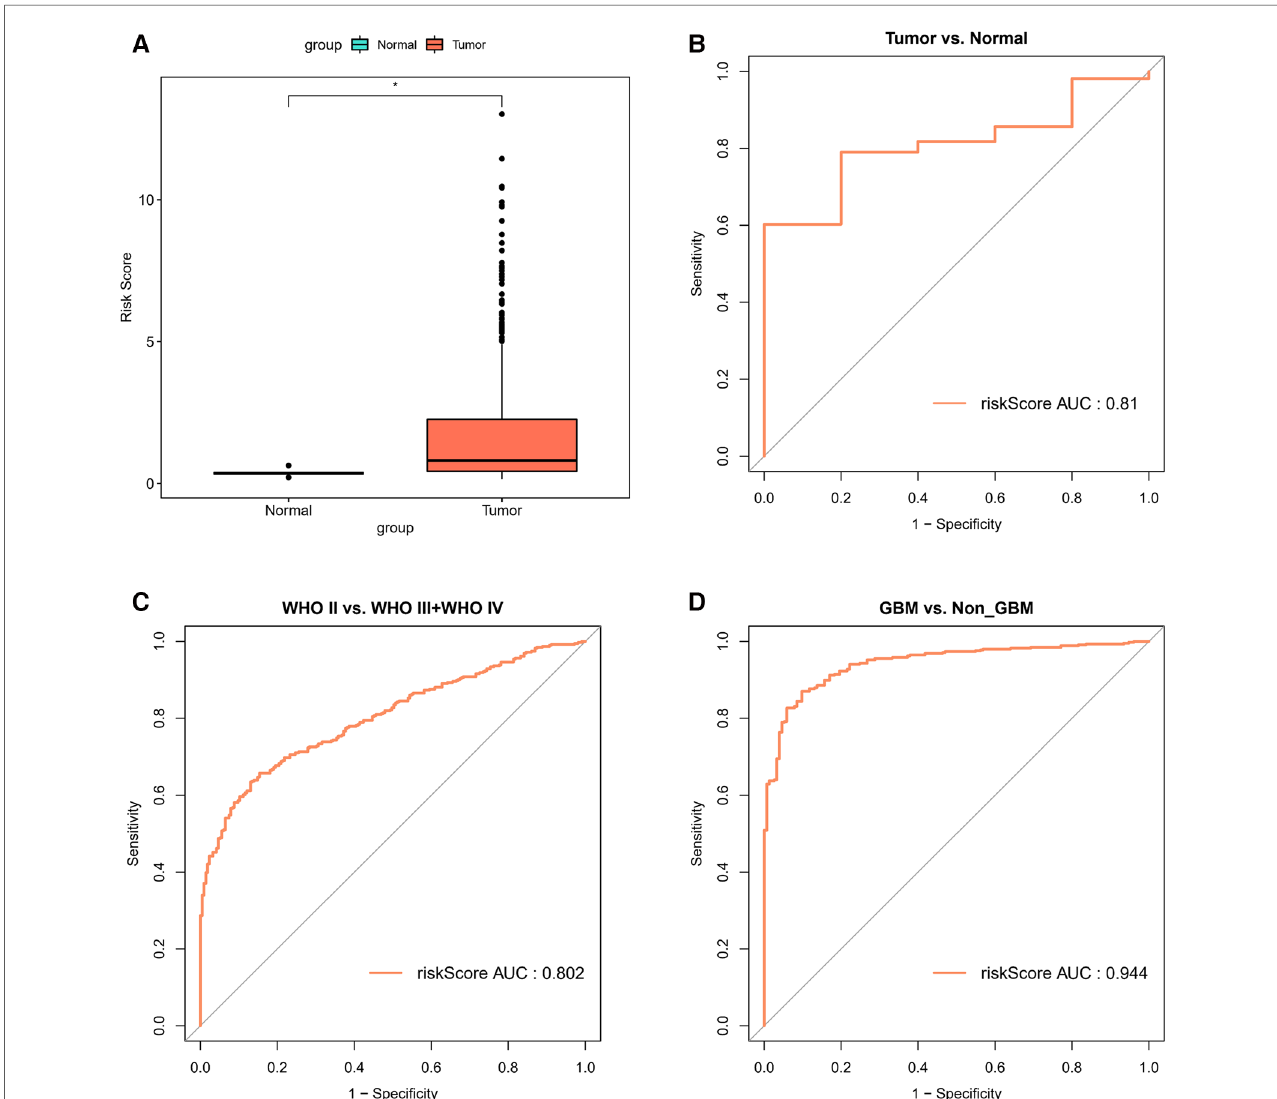
FIGURE 6 Correlation analysis of risk model and clinical factors ( A ) comparison of differences in risk scores between tumor and normal samples. ( B ) The ROC curves for risk score differentiation between Tumor and Normal samples. ( C ) The ROC curves for Grade4 and Grade2+Grade3 samples with risk score differentiation. ( D ) The ROC curves for GBM and non-GBM samples with risk score